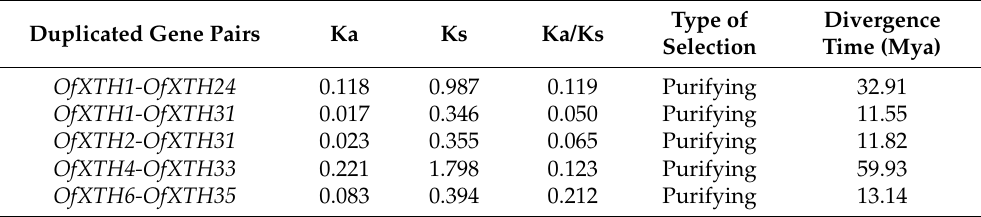
Figure 3. Chromosomal distribution of OfXTH genes. Table 2. Ka/Ks analysis and estimated divergence time of OfXTHs